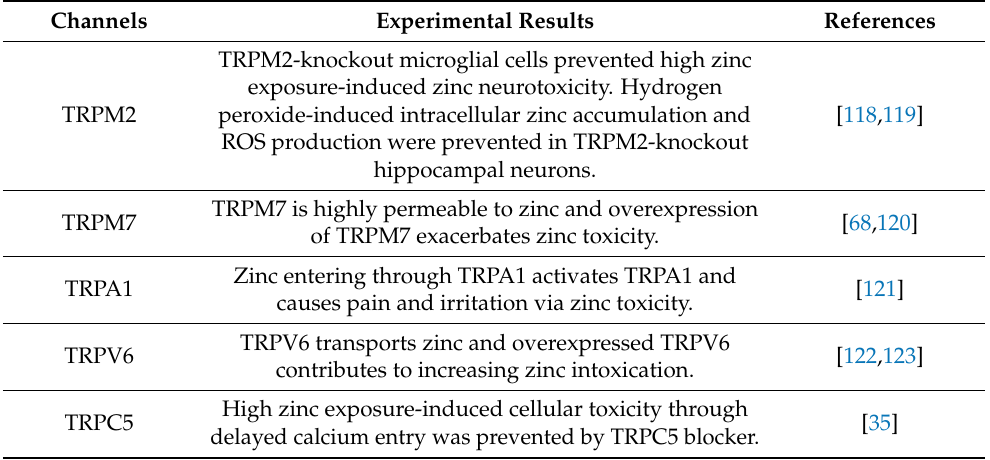
Table 1. Zinc-permeable and sensitivity of TRP